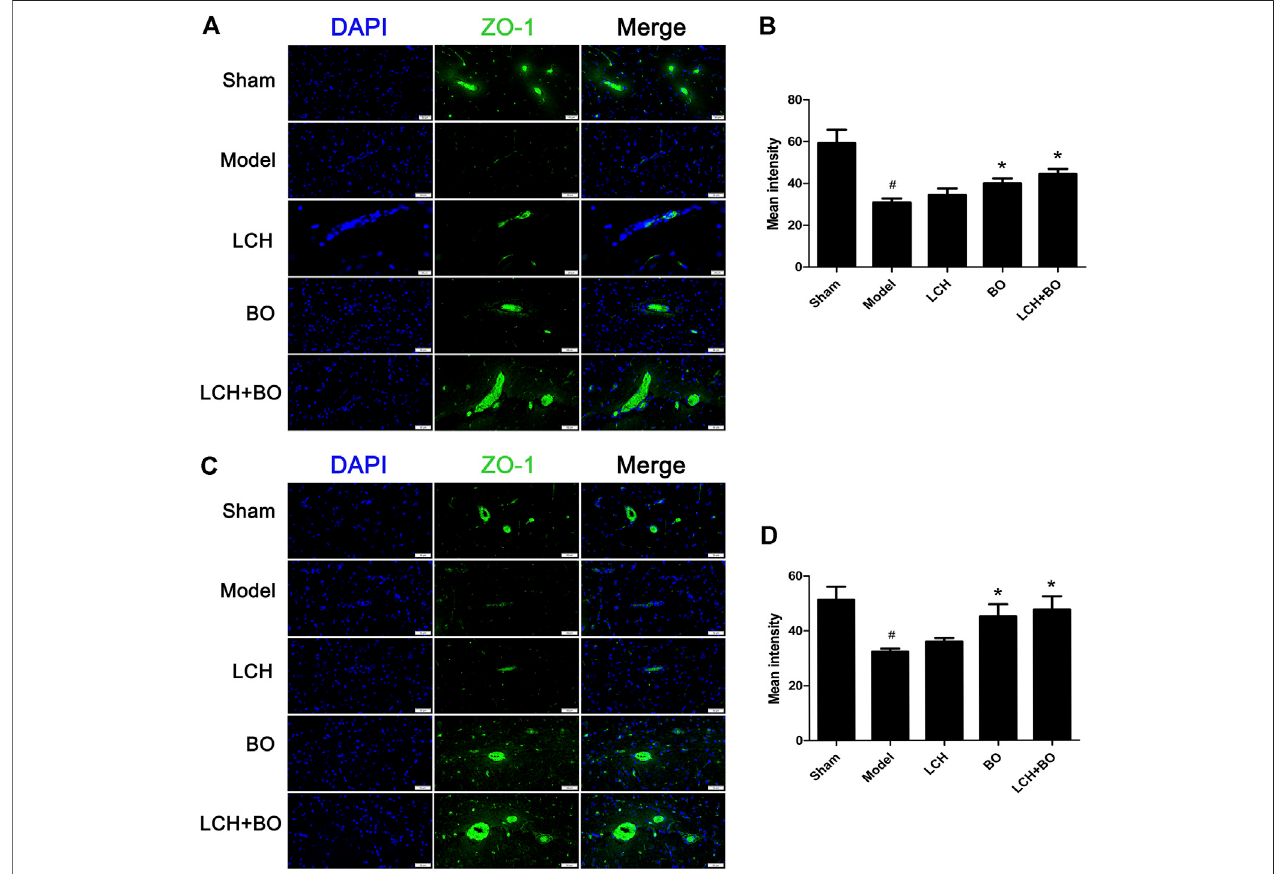
FIGURE13| ExpressionsofZO-1withinDGand SVZofMCAOrats. (A) Representativeimmunostaining imagesofZO-1intheDGarea. (B) Theresultsofaverage fl uorescence intensities of ZO-1 in the DG area ( n (cid:1) 3). (C) Representative immunostaining images of ZO-1 in the SVZ area. (D) The results of average fl uorescence intensities of ZO-1 in the SVZ area ( n (cid:1) 3). # p < 0.05 compared to the sham group; * p < 0.05 compared to the model